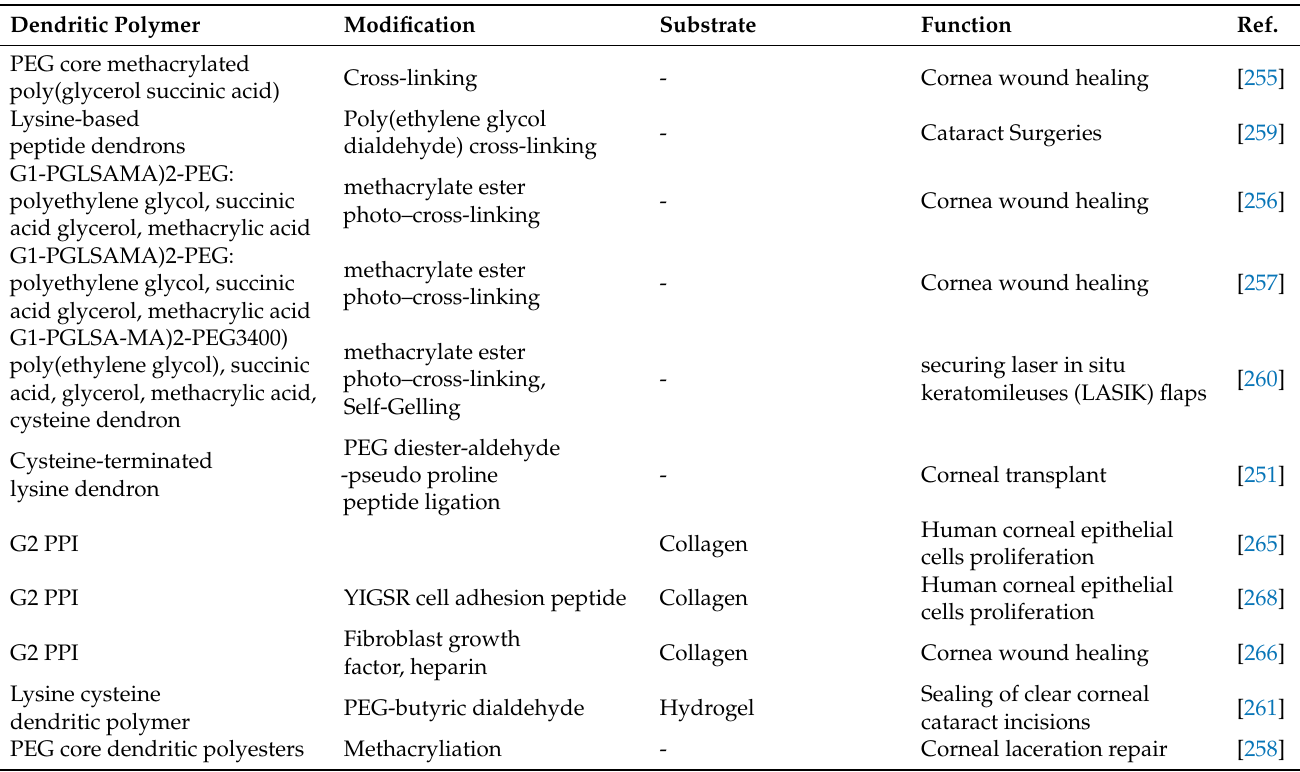
Table 5. Dendritic Polymers for the remediation of